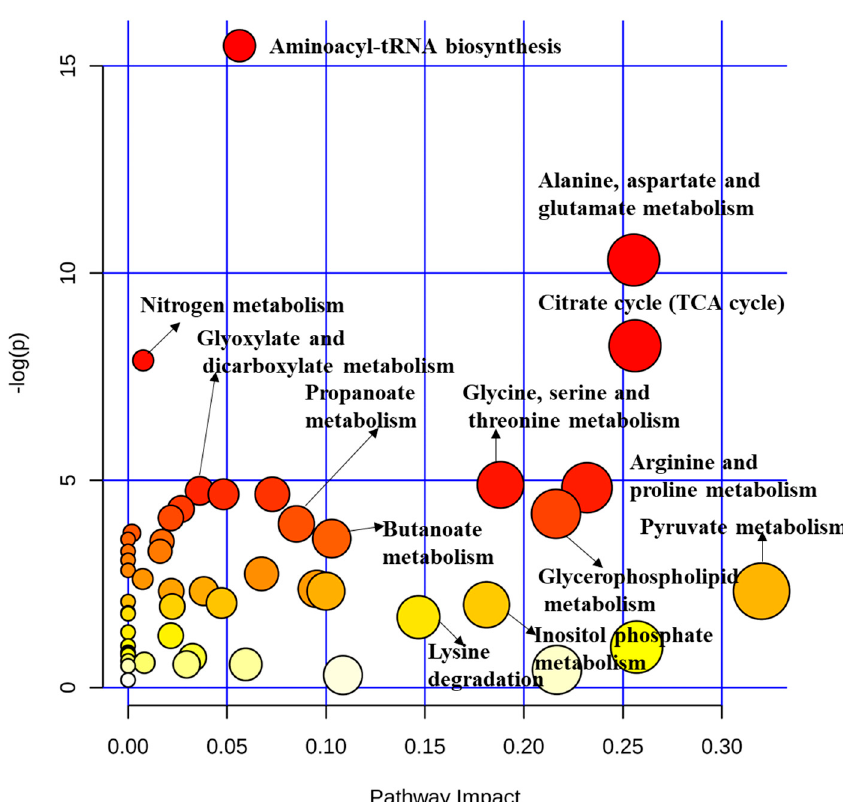
Figure 1. Significantly changed pathways of serum metabolites in pigs a ff ected by the infusion of sodium butyrate (SB) from a whole period perspective. Here, the x-axis represents the pathway impact and the y-axis represents the pathway enrichment. Each node marks a pathway, with larger sizes and darker colors representing higher pathway enrichment and higher pathway impact values.